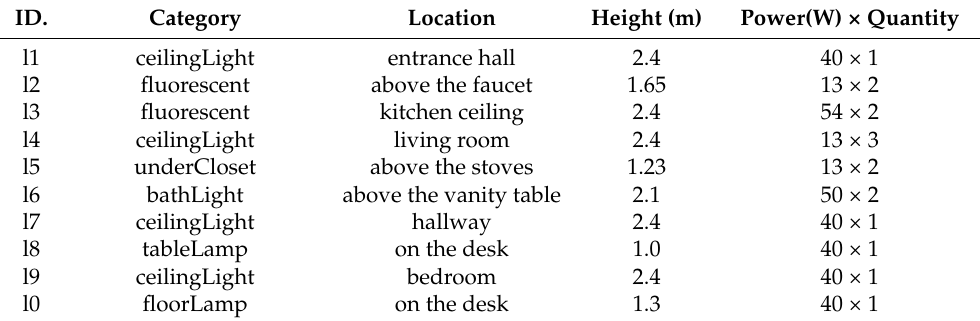
Table 1. Photometry of a